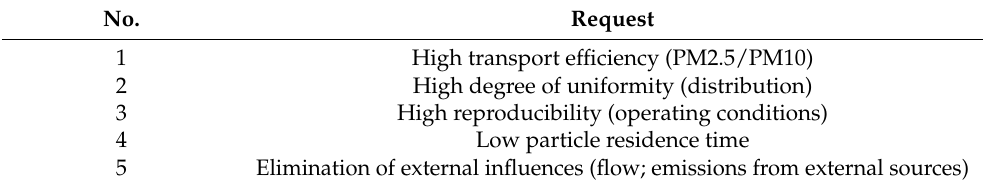
Table 2. Requirements for the sampling of tire wear particle emissions.